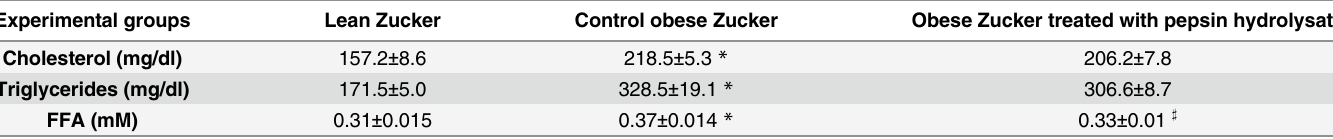
Table 3. Lipid biomarkers in plasma of lean Zucker rats, obese Zucker rats that received water (control), and obese Zucker rats that received 750 mg/kg/day of pepsin for 12 weeks. Values are means ± SEM (n = 10). Experimental groups Lean Zucker Control obese Zucker Obese Zucker treated with pepsin hydrolysate Cholesterol (mg/dl) Triglycerides